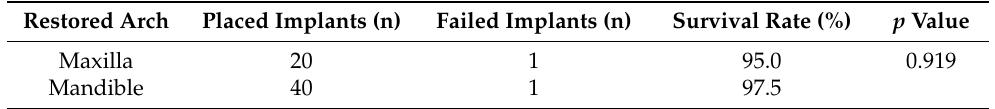
Table 5. Survival rate according to restored